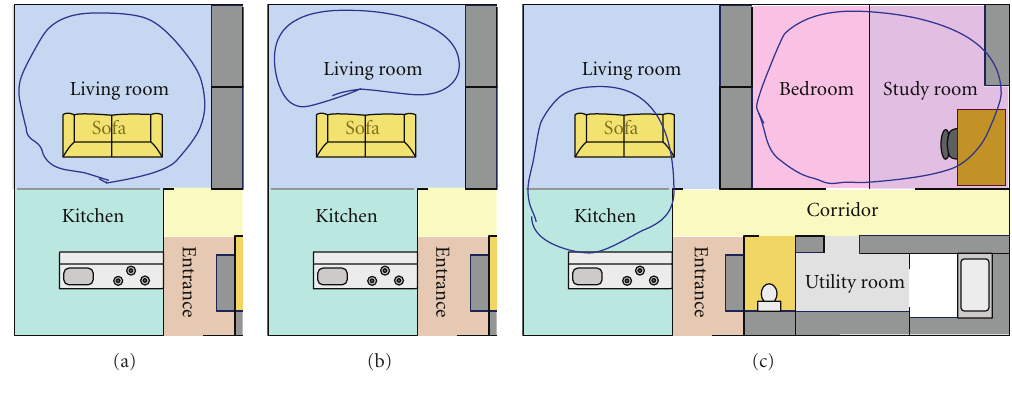
Figure 11: Type 1 queries using the new